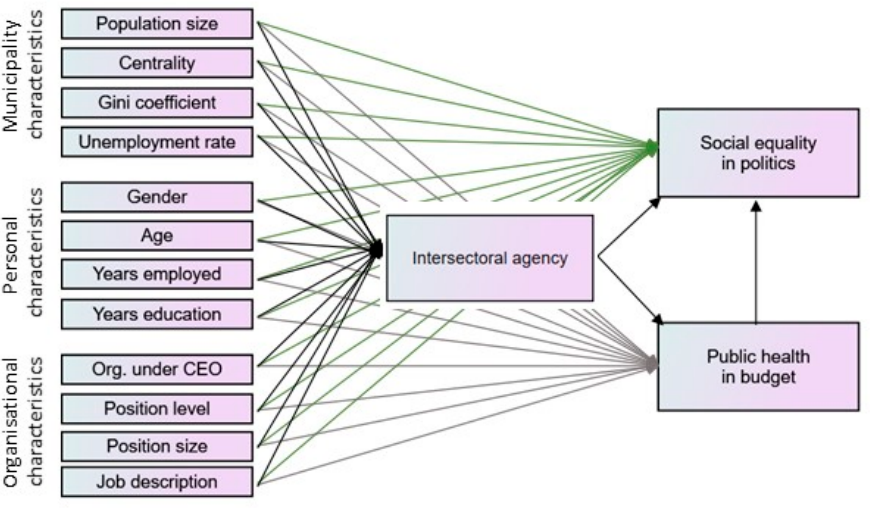
Figure 1. Analytical model.